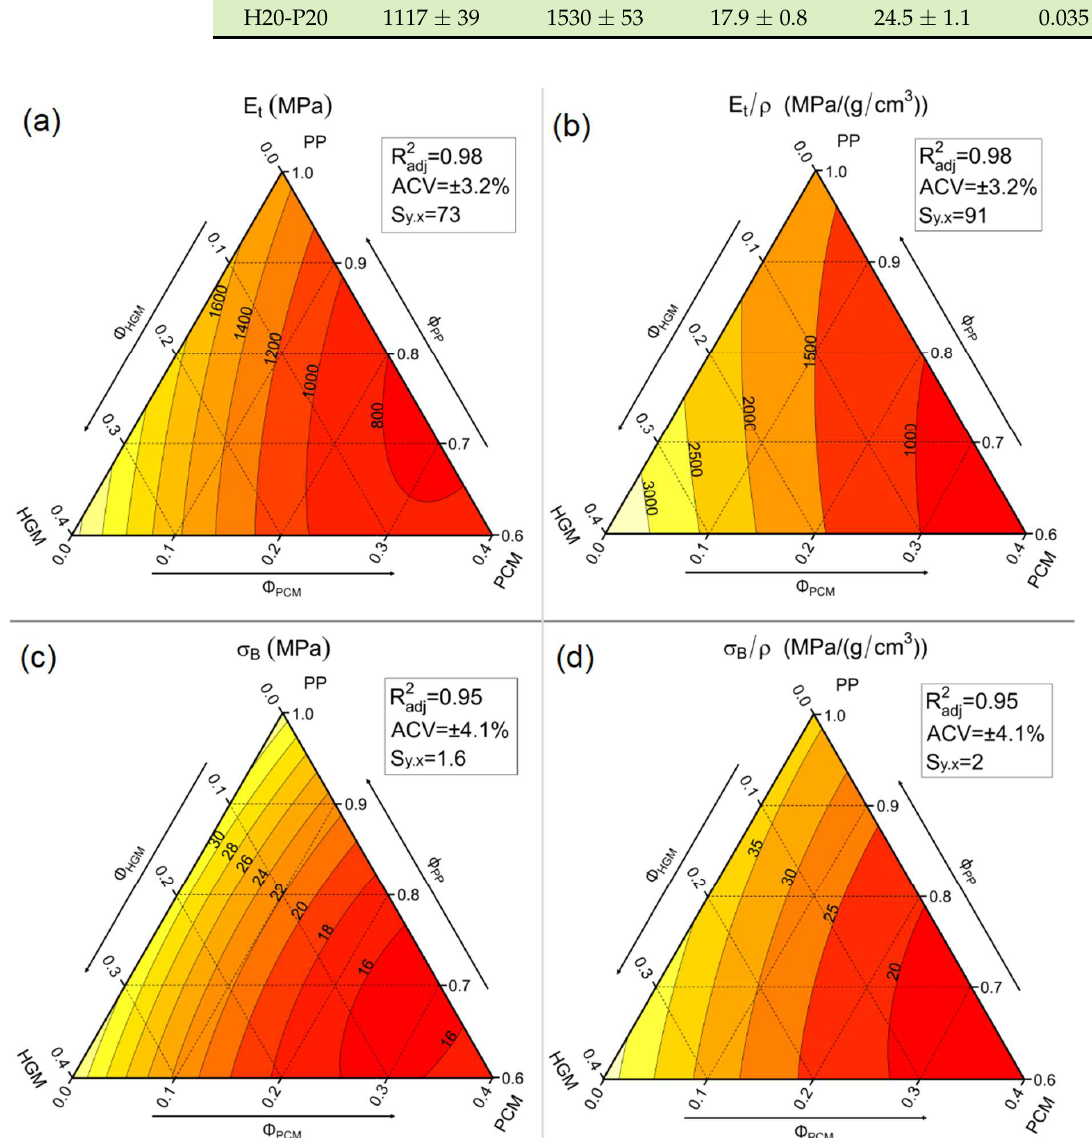
Figure 10. Ternary diagrams of the quasi-static tensile properties of the considered syntactic foams. ( a ) Elastic modulus (E t ), ( b ) specific elastic modulus (Et/ ρ ), ( c ) tensile stress at break ( σ B ), and ( d ) specific stress at break ( σ B / ρ Figure 9 evidences a neat drop in tensile strain of all the compositions containing fillers (PCM or HGMs) compared to the neat matrix. The compositions that better perform in this sense are those incorporating only PCM capsules, where H0-P30 shows a strain at break “only” 80% lower than the PP matrix. Similarly, samples containing only HGMs exhibit the worst situation, with a strain at break decrease of 84% compared to the matrix. Concerning the elastic modulus, Figure 9 reveals the benefits provided by HGMs, by in- creasing the stiffness from 1509 MPa of the matrix up to 2480 MPa of the H30-P0 foam (+64%). This is due to the stiff nature of HGMs. On the other hand, PCMs reduce the elastic modulus from 1509 MPa down to 758 MPa of H0-P30 foam (−50%), because of the limited stiffness of the PCM capsules. These trends are better represented in the ternary diagram of Figure 10a. This diagram also shows a proportionality of the elastic modulus when the PCMs are substituted by an equivalent volumetric amount of HGMs (by moving horizon- tally from right to left in the graph). The normalized elastic modulus, shown in Figure 10b, displays an analogous situation where Et/ ρ proportionally changes with the PCM degree of substitution with HGMs. As for the elastic modulus, the stress at break is also